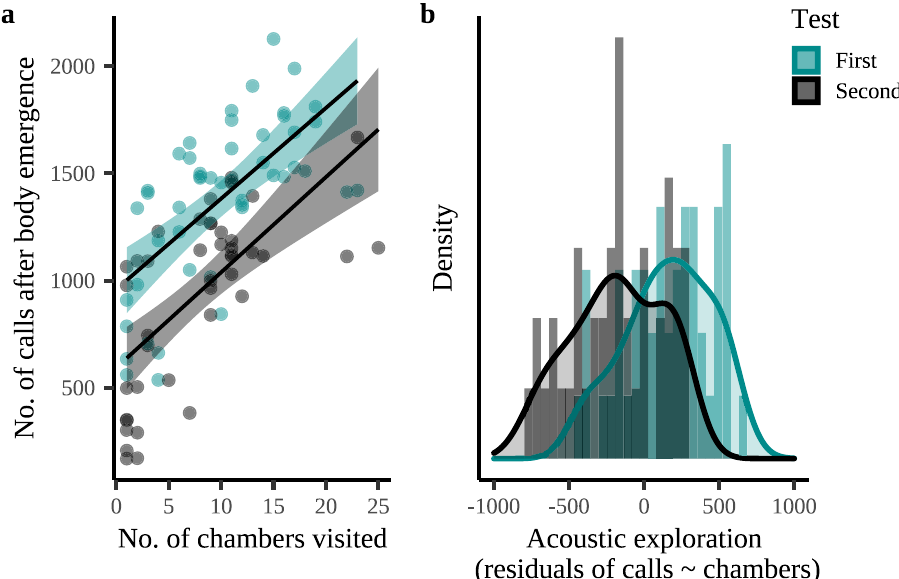
Figure 2. The number of echolocation calls emitted during the first and second test as a function of the number of chambers visited by Nathusisus’ pipistrelles in a novel environment. ( a ) Bats emitted more echolocation calls during the first 2 min in the novel environment (a maze-like arena) when they also visited more chambers. ( b ) Bats varied substantially in how much more or less they echolocated than expected based on the number of chambers they visited, i.e., the residuals of the number of echolocation calls as a function of the number of chambers visited varied considerably. Regression lines in panel ( a ) show the predicted final model values. Shaded areas around the lines reflect the 95% Confidence Interval. Lines in panel ( b ) show the density distribution while the bars show the frequency